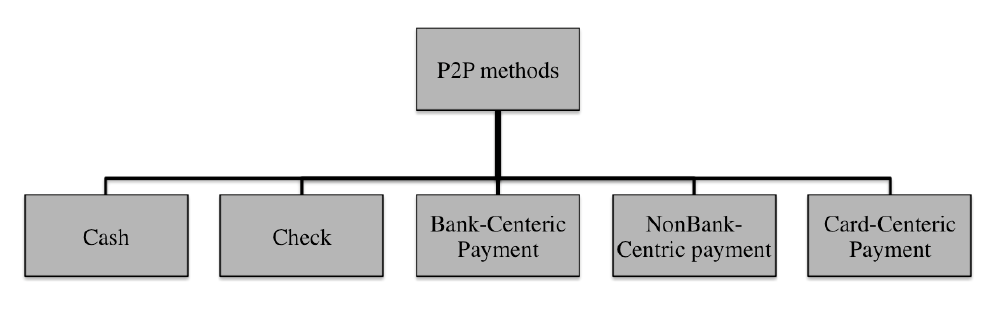
Figure 1. Different person-to-person payment system